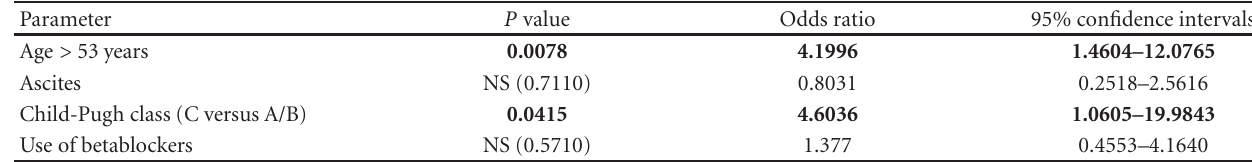
Table 5: Results of multivariate regression analysis with regard to the presence or absence of left ventricular diastolic